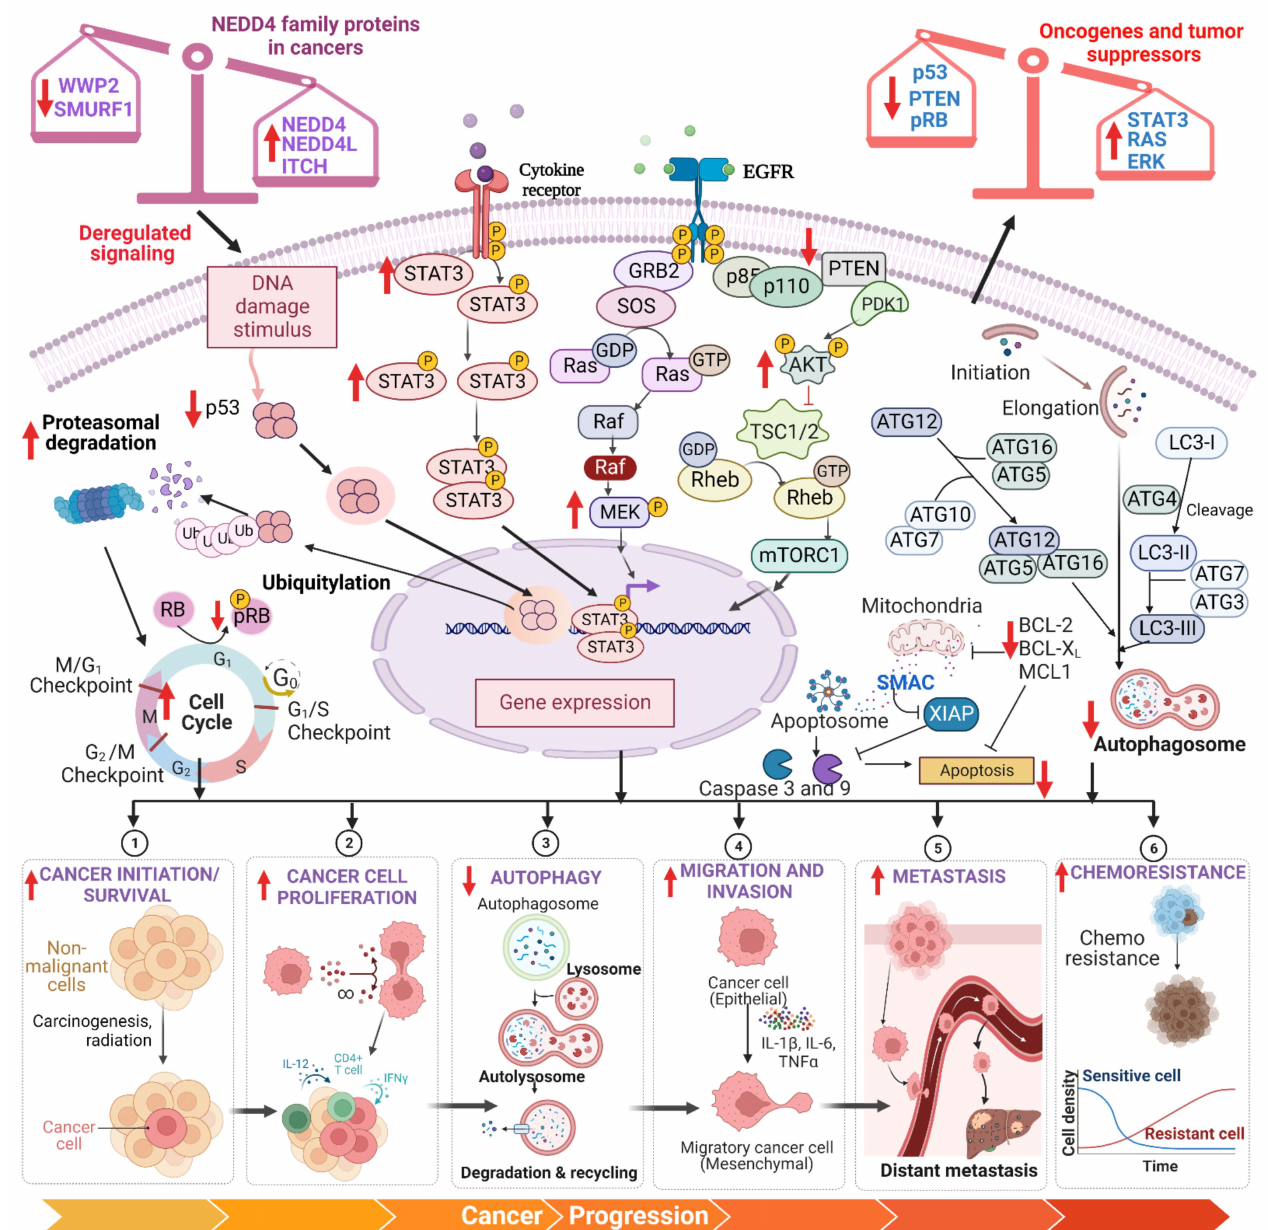
Figure 5. Role of NEDD4 family proteins in cancer development and progression. A plethora of studies have shown that NEDD4 family proteins are deregulated in various cancers. The imbalance in the expression of tumor-growth-promoting NEDD4 family proteins such as NEDD4, NEDD4L, ITCH, and WWP1 and tumor-growth-suppressing NEDD4 family proteins such as WWP2 and SMURF1 independently leads to increased proteasomal degradation of p53, downregulation of PTEN and pRB, and upregulation of STAT3, Akt, MEK, MMP-1, and MMP-13. This disproportion in the expression of tumor suppressors and oncogenes promotes cancer cell initiation, survival, proliferation, migration, invasion, metastasis, and chemoresistance and inhibits apoptosis and autophagy. Created using